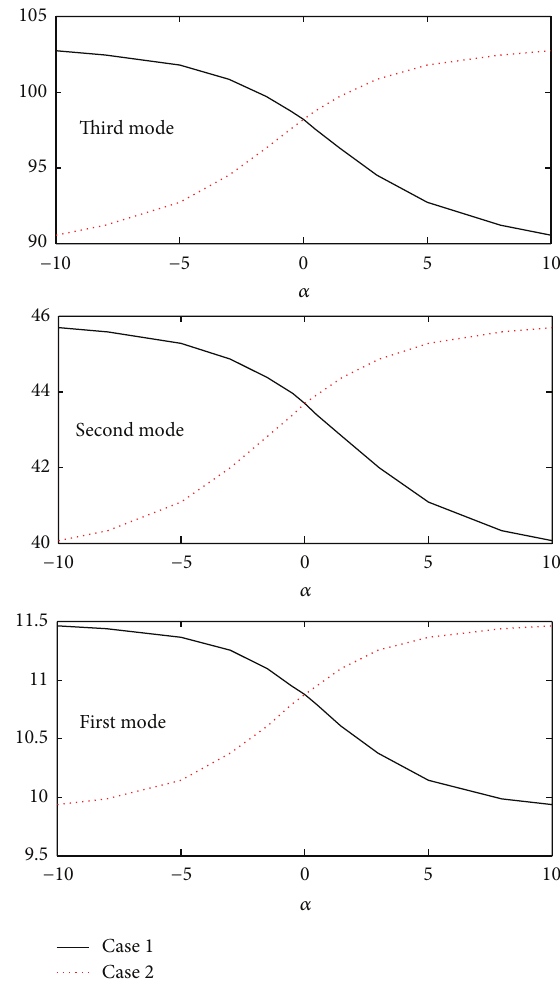
Figure 13: Variation of first three nondimensional natural frequen- cies of an axially FG beam with respect to 𝛼 ; boundary condition: